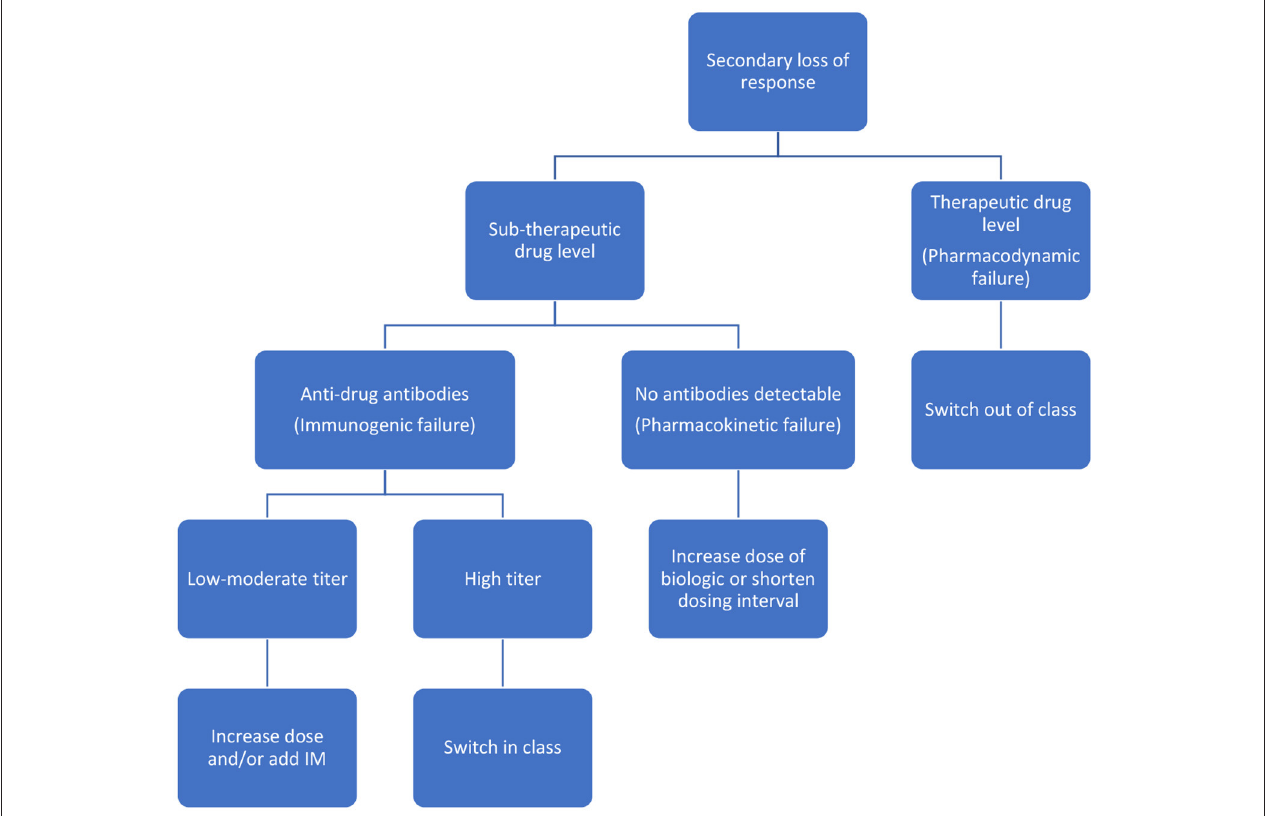
FIGURE 3 | Reactive drug monitoring scenarios and management strategies during